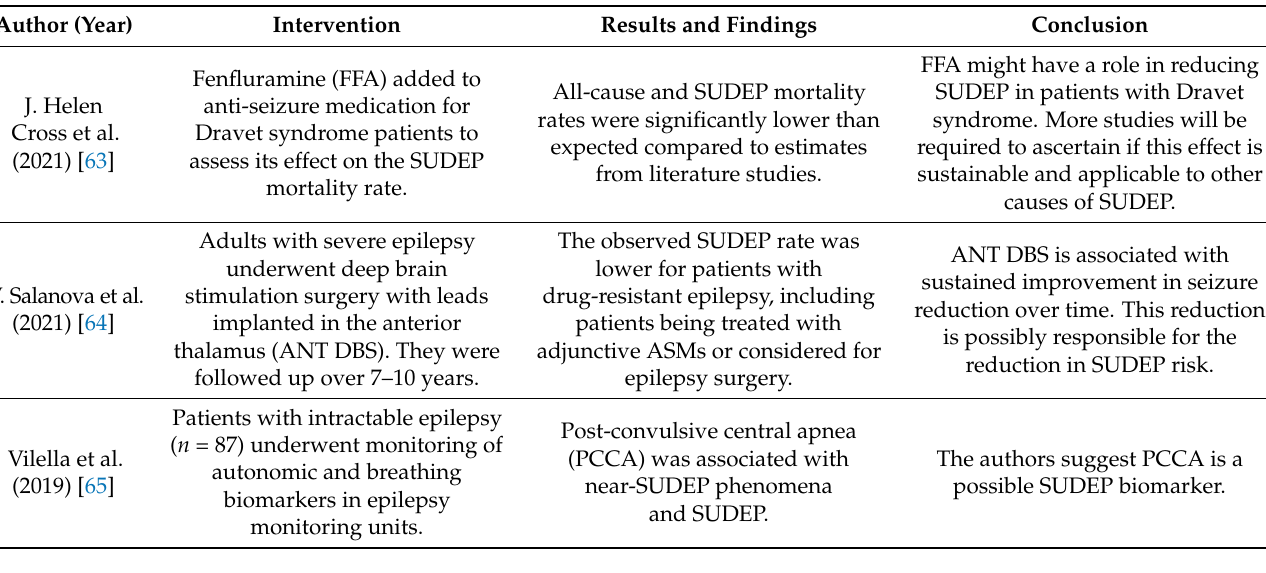
Table 3. Clinical efficacy and